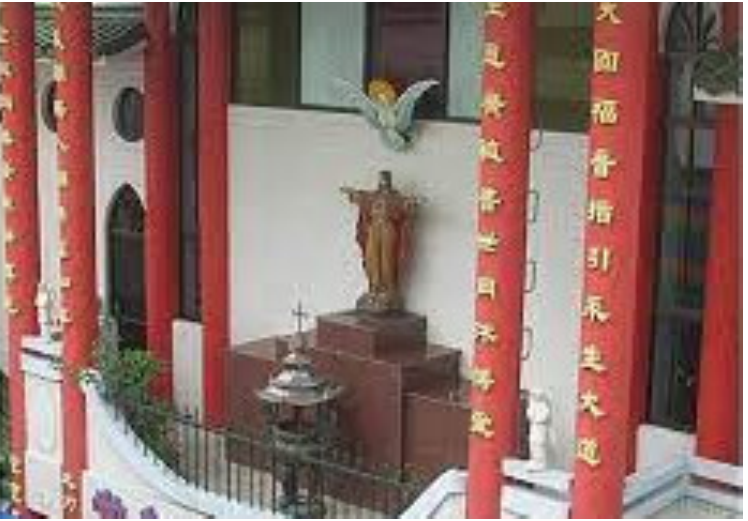
Figure 9. The church of Saint Caterina da Siena in Kaohsiung 高 雄 聖 加 大 利 納 堂 . The incense brazier is located on the terrace of the second